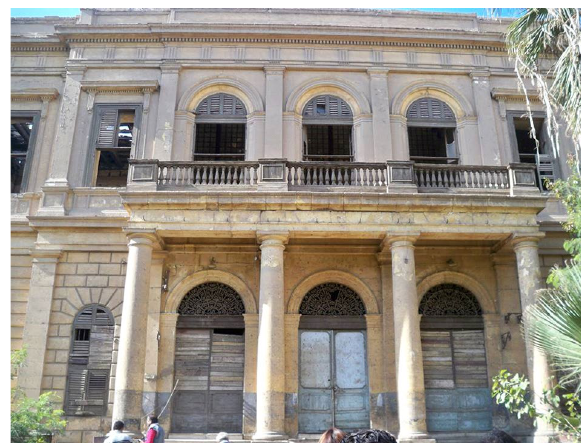
Figure 7. The front façade of Tosson Palace in Cairo- Egypt